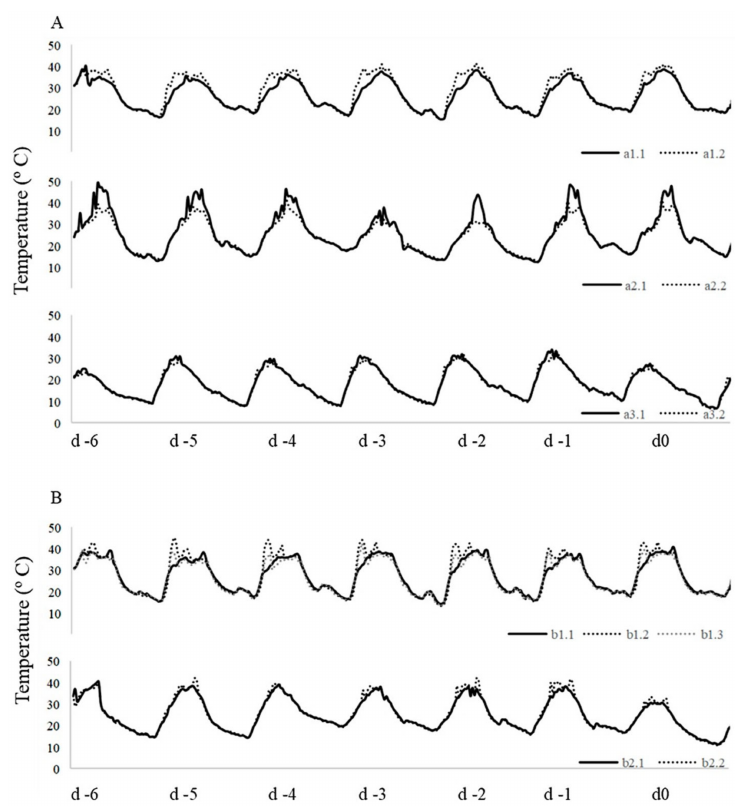
Figure 1. Average daily temperature ( ◦ C) over the last six days before harvest for each variety and treatment. Continuous lines correspond to control cultivars while dotted lines represent treatments. The image shows ( A ) the use of elicitors and ( B ) canopy management